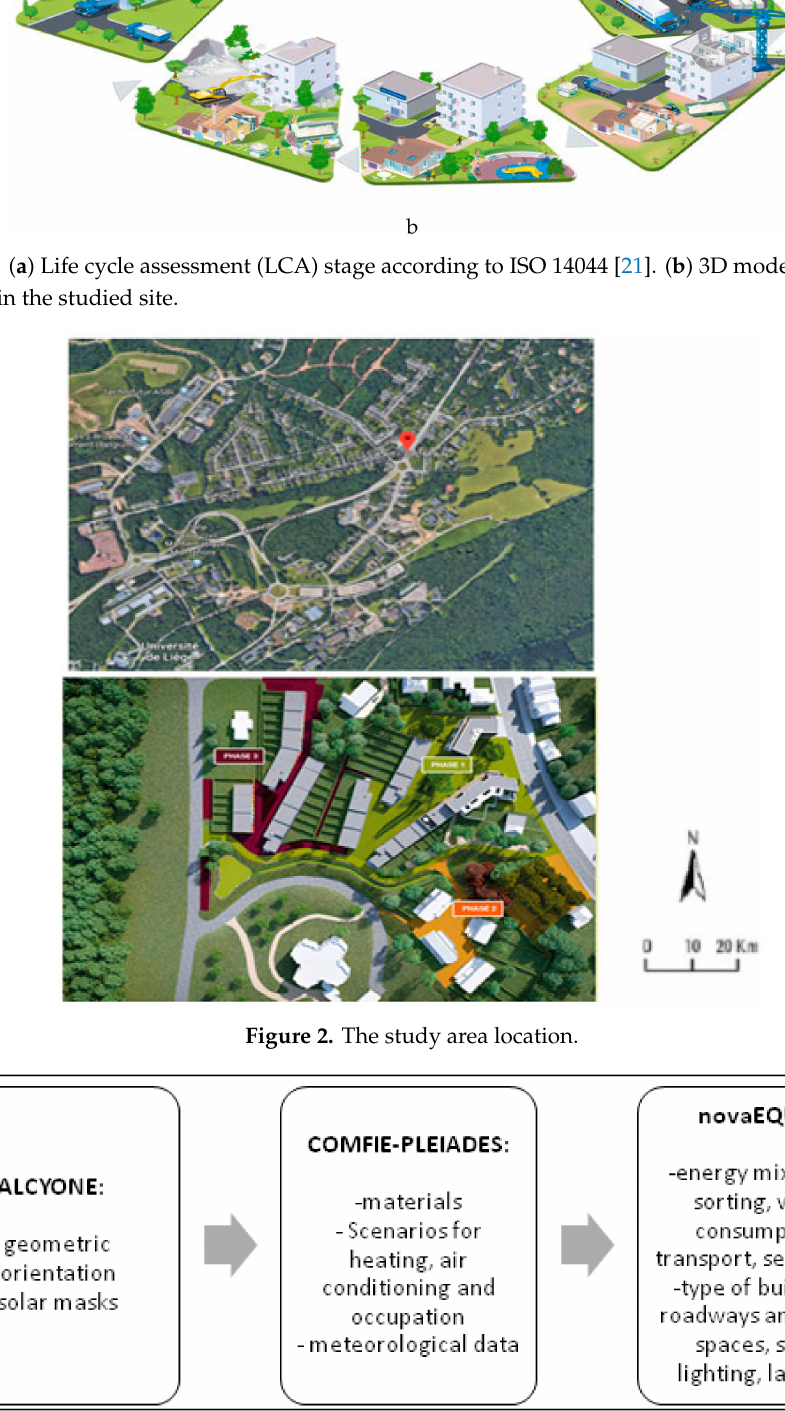
Figure 3. Chaining analysis software. The neighborhood studied was newly built by the Belgian government by adopting the concept of sustainable